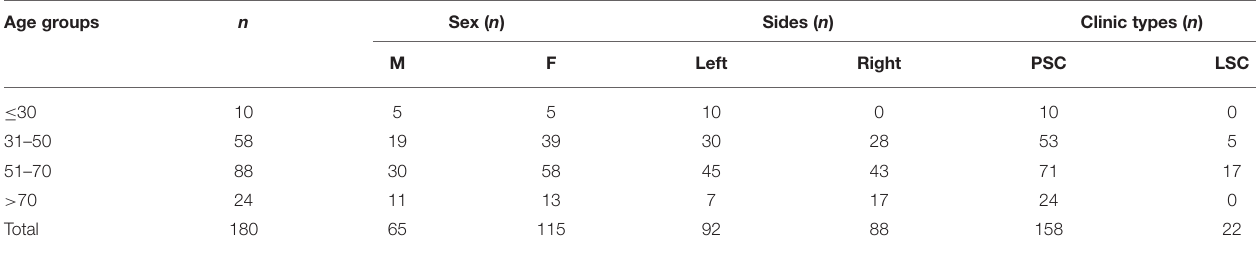
TABLE 1 | The clinic data of 180 patients with benign paroxysmal positional vertigo (BPPV). Age groups